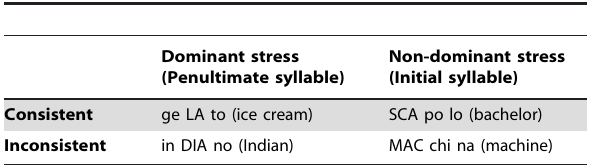
Table 1. Examples of Italian words with dominant and non- dominant stress pattern and a consistent or inconsistent